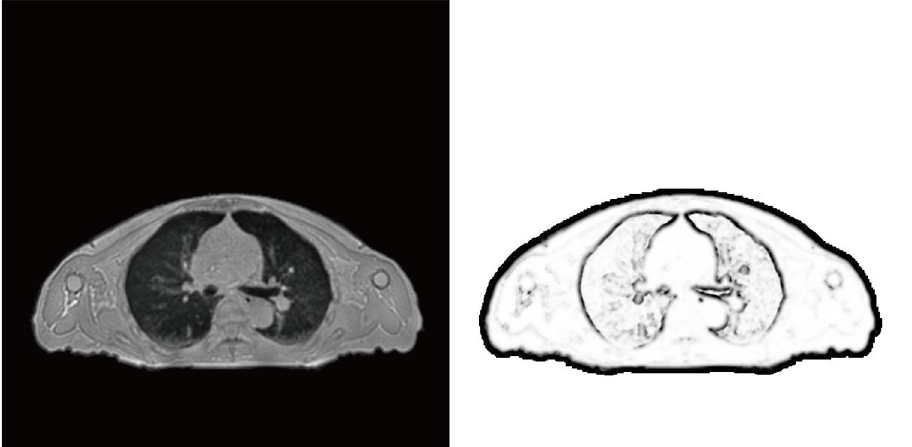
Figure 2. MRI and the corresponding MIND